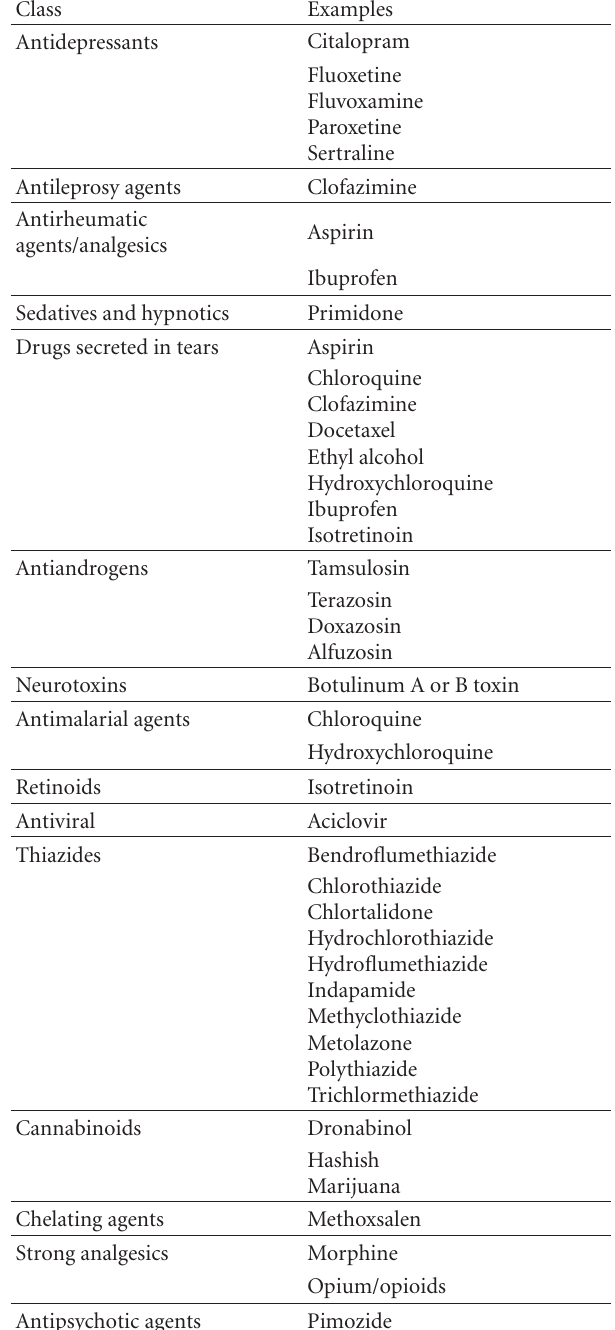
Table 3: Systemic drugs probably causing or aggravating dry eyes [13].